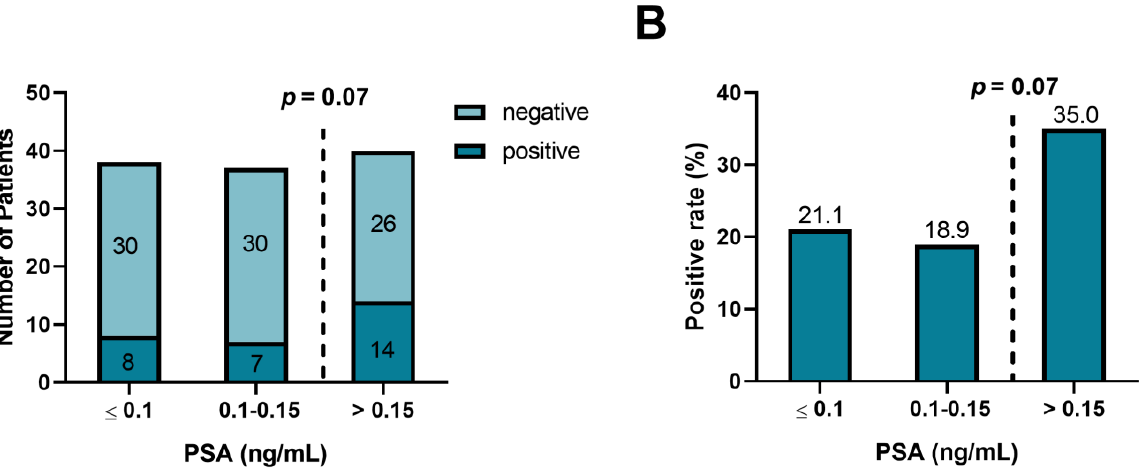
Figure 3. Detection rate on 68 Ga-PSMA-PET/CT of lesions suspicious for prostate cancer by PSA level subgroup in 115 men with BCR and very low serum PSA concentration. Panel A depicts the numbers of patients with scans positive or negative for suspicious lesions, while Panel B provides detection rates in percent (numbers atop the bars). Patients with PSA > 0.15 – 0.2 ng/mL have a substantially higher detection rate than their counterparts with PSA ≤ 0.15 ng/mL, but the difference does not reach statistical significance ( p = 0.07).